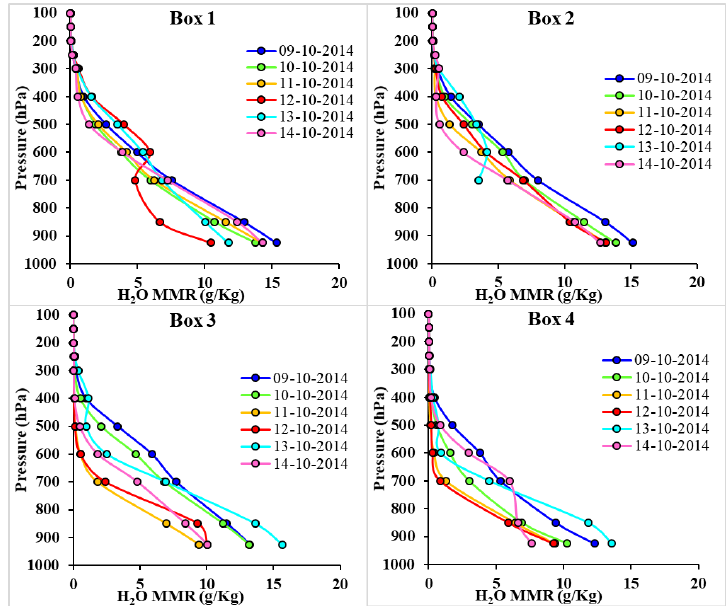
Figure 12. Vertical Profile of H 2 O MMR for 9 – 14 October 2014.